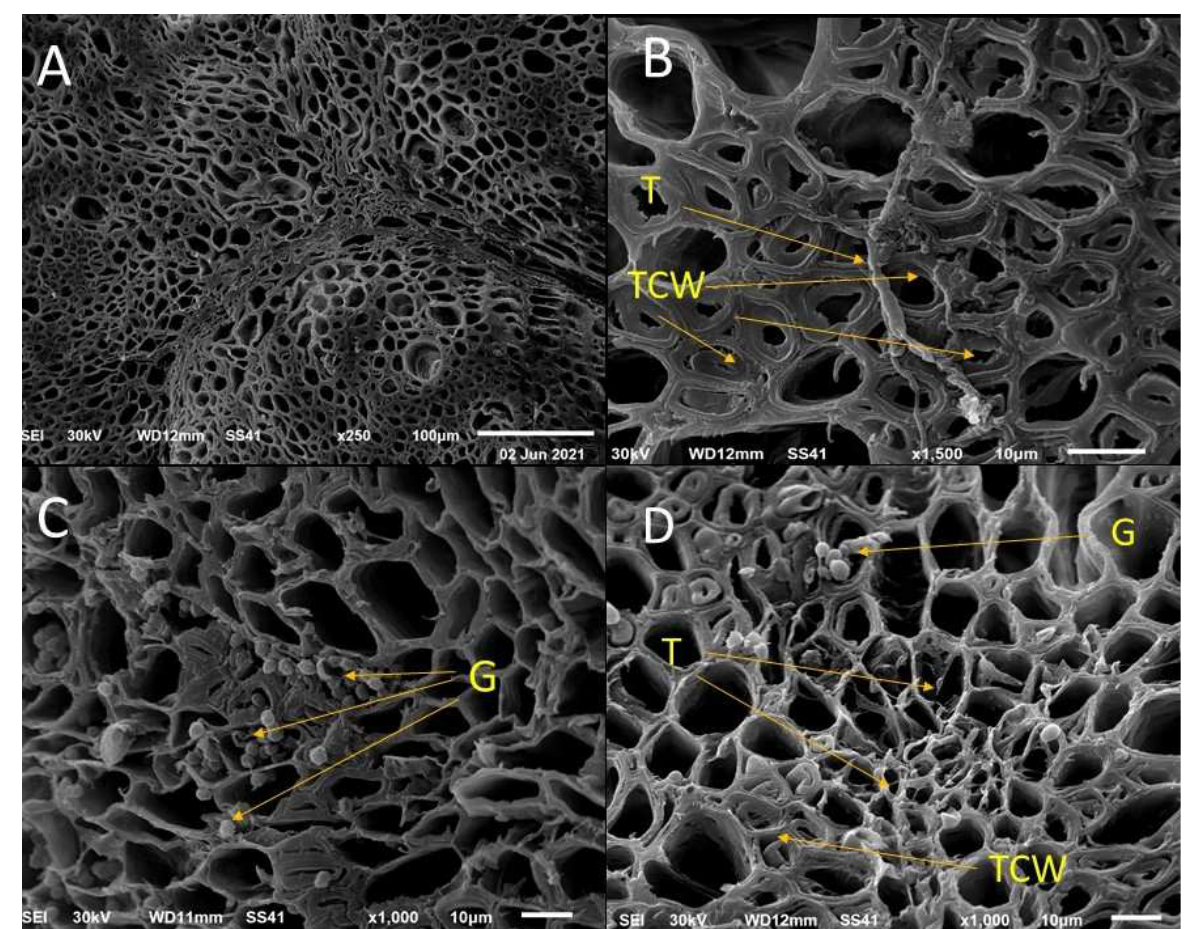
Figure 7. Micrographs of the SEM cross-section of pea root after 30 days of planting showing; ( A ): normal control plants, ( B ): plants treated with T. asperellum ZNW only, ( C ): plants grown in infested soil by G. ultimum NZW, and ( D ): plants treated with T. asperellum ZNW under infested soil by G. ultimum NZW. T-arrow: T. asperellum hyphae, TCW-arrow: thickening in cell wall vessels (TCW), G-arrow; G. ultimum NZW